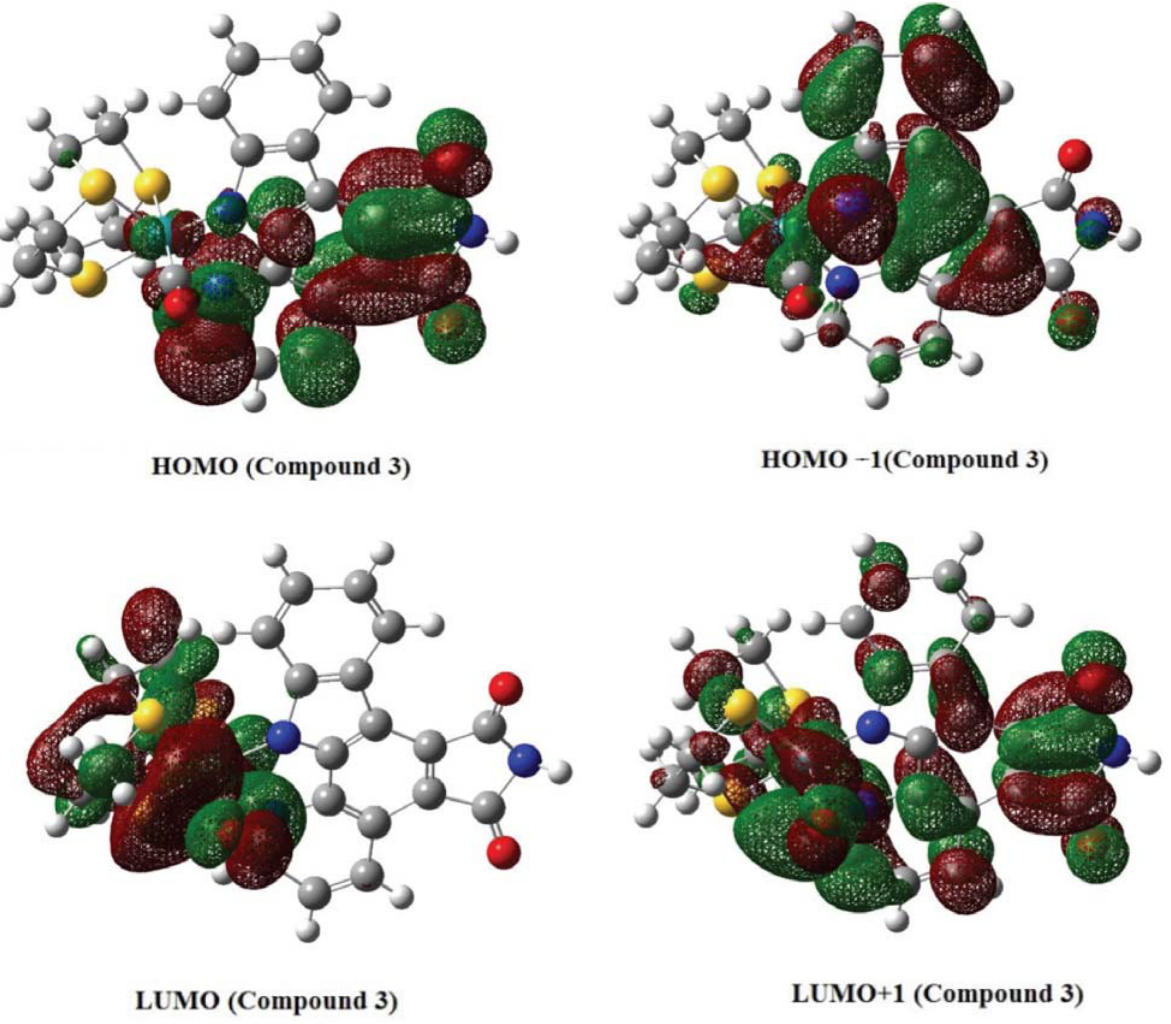
Figure 6. HOMO and LUMO molecular orbitals of the staurosporine complex ( 3 ) using the LANL2DZ method.